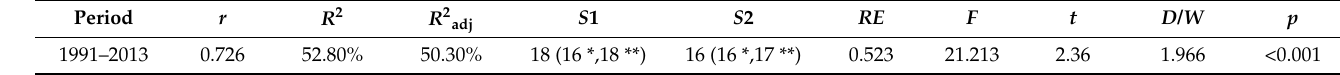
Table 3. Leave-one-out cross validation statistics for the annual maximum NDVI